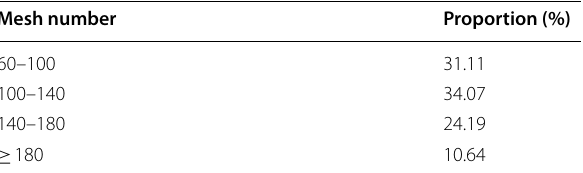
Table 1 The proportion of different mesh number of